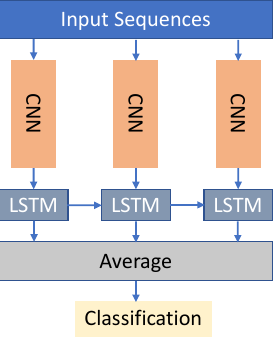
Figure 13. Hybrid deep learning model. Table 3. Hybrid feature based state-of-the-art methods for